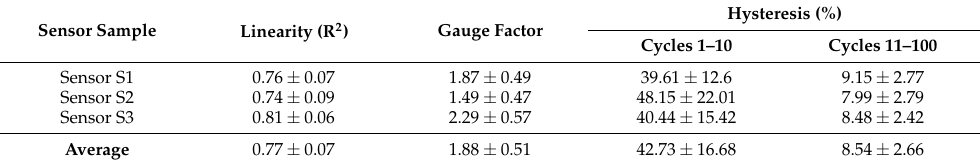
Table 1. Average sensor performance metrics. Each column in the table represents a specific parameter for a sensor sample (rows) averaged across all 100 cycles (except for the hysteresis score) over its specific working range. For reference, the maximum strain applied to each sensor sample was 66%.